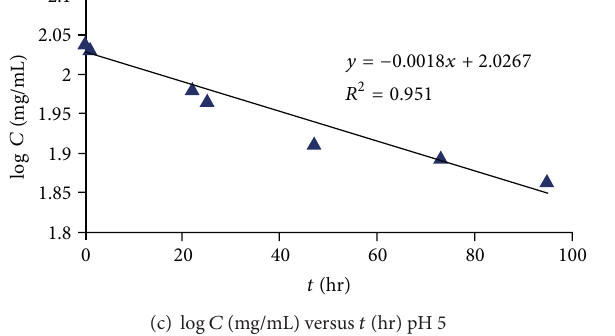
Figure 7: First-order hydrolysis plot of atenolol ProD 1 in (a) 1 NHCl, (b) buffer pH 2, and (c) buffer pH 5.